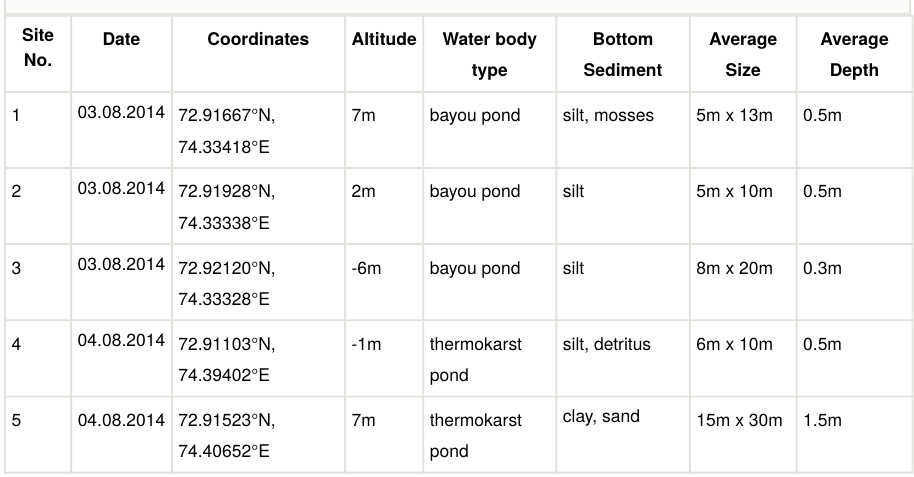
Table 1. Locations and dates of sampling with notes on the water body type and substratum (bottom